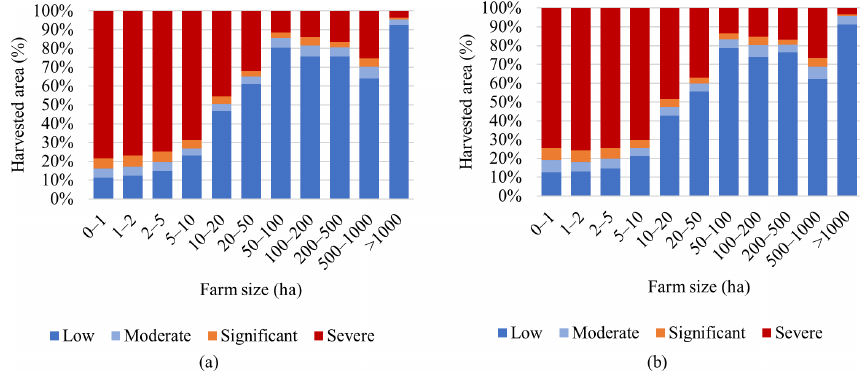
Figure 9. Blue water scarcity levels (WSL) within each farm size according to our farm-size-specific and crop-specific harvested area dataset based on the GAEZv4 crop map (a) and the SPAM2010 crop map (b) under the four blue water scarcity levels (WSL) of Mekonnen and Hoekstra (2016). Low blue WSL indicates blue water consumption does not exceed blue water availability, moderate WSL indicates blue water consumption is 100%–150% of blue water availability, significant WSL indicates blue water consumption is 150%–200% of blue water availability and severe WSL indicates blue water consumption is larger than 200% of blue water